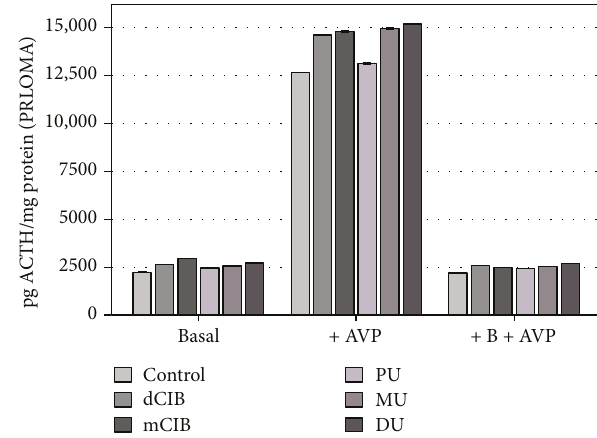
Figure 3: EDC e ff ects in the regulation of ACTH release on normal rat AdH cultures, in vitro . Mean (ACTH level) ± SEM.